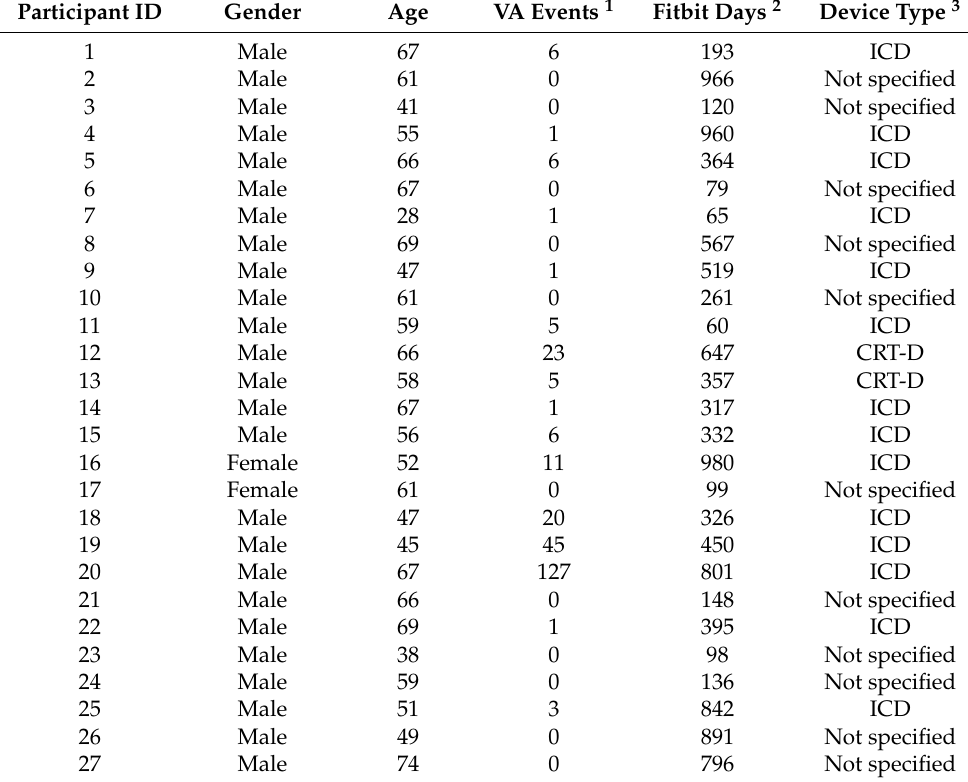
Table 4. Participant